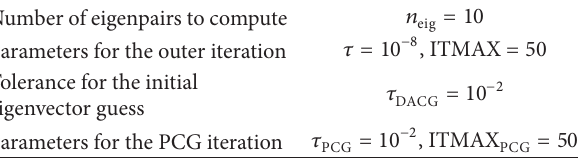
Table 2: Default values of parameters.